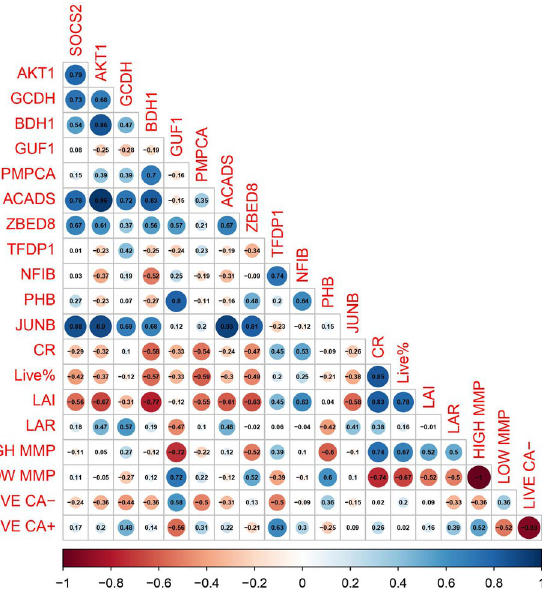
Figure 9. Correlation matrix of sperm functional parameters with selected genes involved in various biological, molecular and cellular components of metabolic pathways.